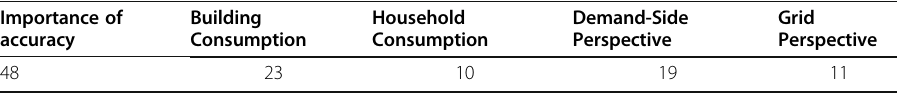
Table 3 Number of references for each focus aspect Importance of